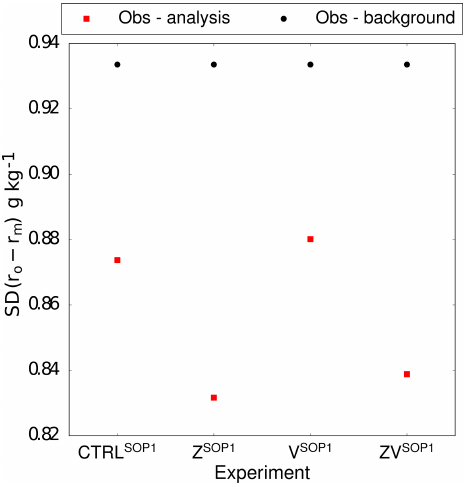
Figure 11. Standard deviation (gkg − 1 ) of the water vapour mixing ratio differences between in-flight humidity measurements r o and the analyses r m for the different experiments (CTRL SOP1 , Z SOP1 , V SOP1 and ZV SOP1 ) over the 24 analyses. The standard deviation differences between the measurements and the background state are also shown by the black data points ( N =